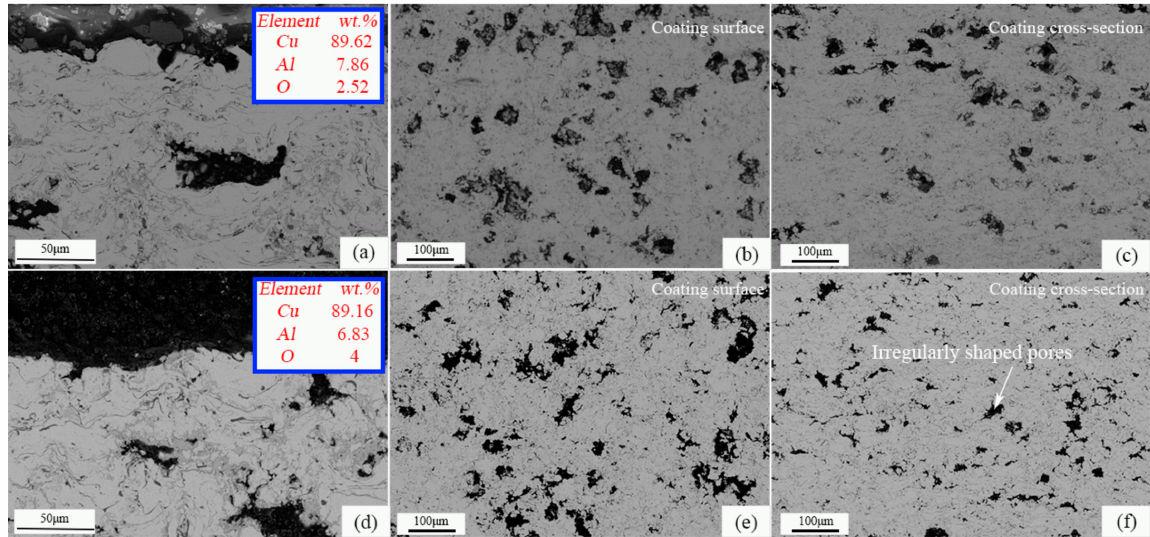
Figure 12. Microstructure and pore distribution of the CuAl seal coatings under constant temperature oxidation at 500 ◦ C for ( a – c ) 500 h; ( d – f ) 1000 h.